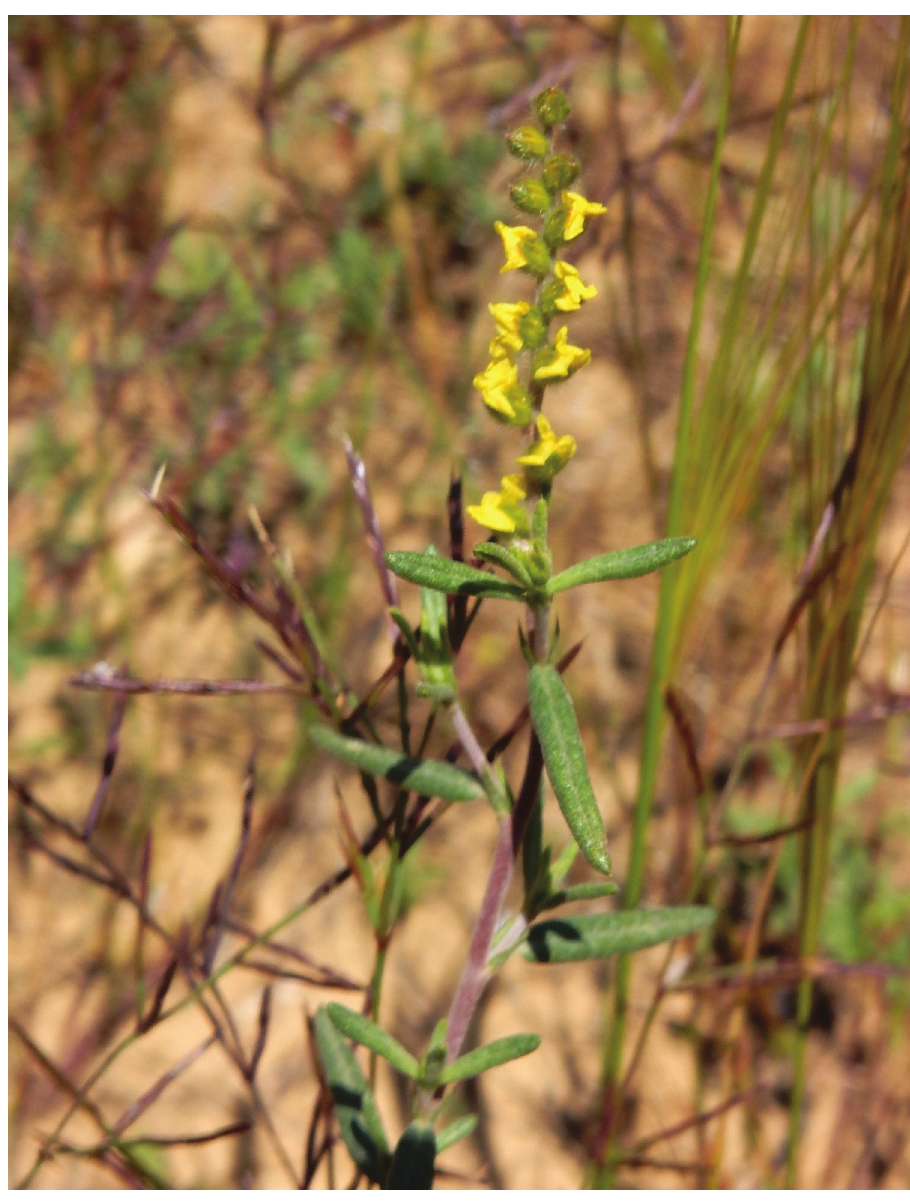
Figure 5. Helianthemum lippii in Sicily. Photograph by G. Domina. 1953, Brullo et al. 1987; Fig. 6), for the northwestern coast of Sicily, and on the southwestern coast of Puglia (observations by P. Medagli and G.N. Silletti). Accord- ing to Venturella et al. (2015), the populations of Helianthemum lippii previously reported from Calabria are currently doubtful and should be excluded from the vascular flora of this